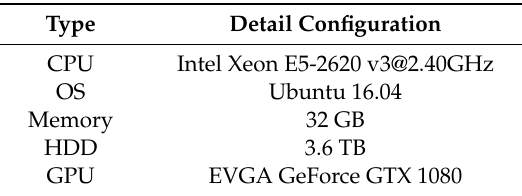
Table 3. Configuration of the